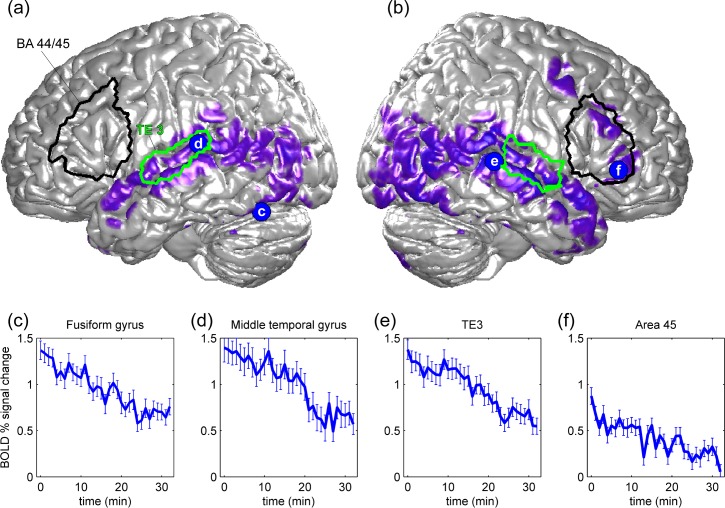
Illustrates significant fMRI blood-oxygen-level dependent (BOLD) signal decline during crying infant (CI) presentations.Significant response decrements (p < 0.05, FWE-corrected) during CI presentations are shown in purple and rendered on a standard brain surface, (a) the left and (b) right hemisphere. The outline of brain-surface projections of the areas BA44/45 and TE3 from a probabilistic atlas system [41,42] are indicated by black and green lines. (c) to (f): Significant BOLD signal decline (i.e., habituation) was found in the fusiform gyrus, middle temporal gyrus, TE3 (superior temporal gyrus [40]), and in the right BA 45. Median percentage of BOLD signal change over the 30 CI presentations for the four example peaks shown in (a) and (b). Error bars indicate standard errors.